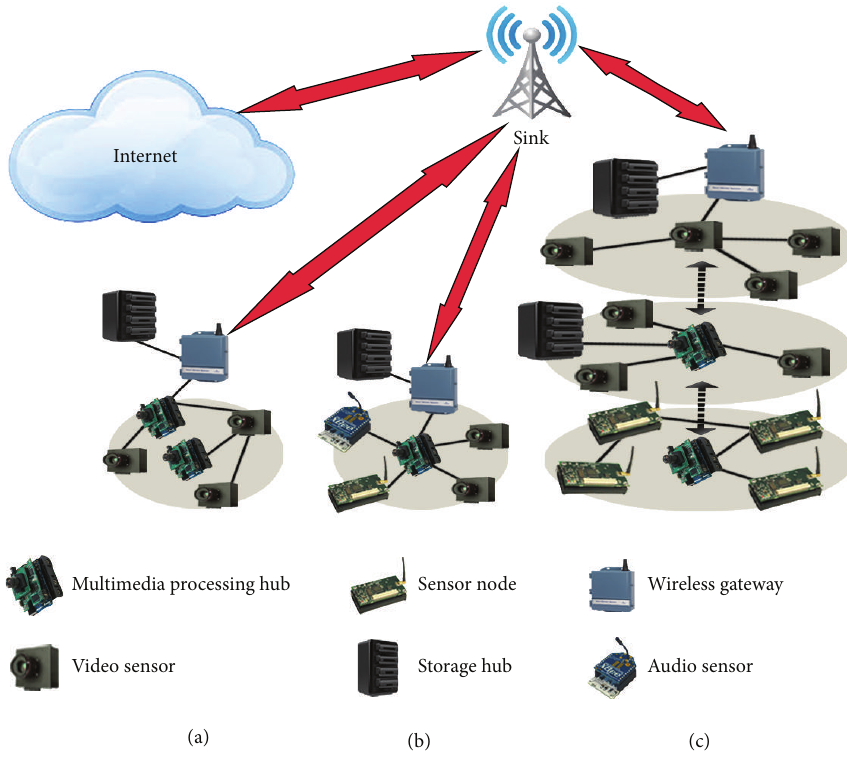
Figure 1: Architecture of